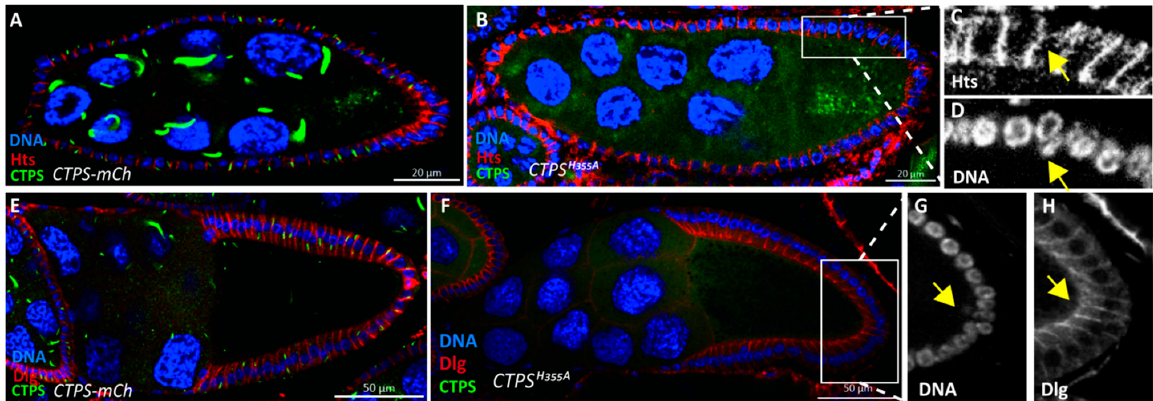
Figure 5. Ingression of follicle cells labeled with different membrane proteins. ( A ) Lateral view of a stage 8 egg chamber. Hts (red) labels the hulitaishao protein mainly presents at the lateral of follicle cell membranes. mCherry-tagged CTPS is shown green, and Hoechst (blue) for DNA. ( B ) A stage 8 egg chamber of CTPS H355A Drosophila . mCherry-tagged CTPS H355A is diffused. ( C ) The Hts pattern of an ingressive follicle cell. ( D ) Yellow arrow pointed out the ingressive cell nuclear. ( E ) Lateral view of a stage 10A egg chamber. Dlg (red) labels the discs large protein, which presents in the lateral and basal side of follicle cell. CTPS-mCherry cytoophidia can be observed, and Hoechst (blue) for DNA. ( F ) Lateral view of the CTPS H355A egg chamber at stage 10A. ( G ) The ingressive cell nuclear is stressed by the yellow arrow. ( H ) The Dlg pattern of the follicle cell ingression.